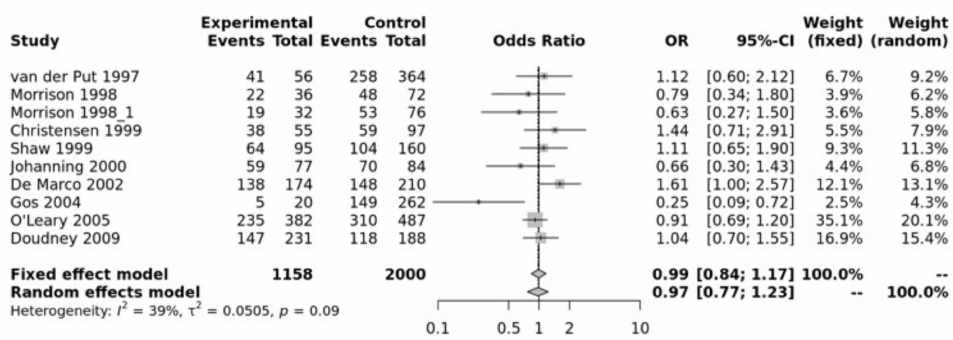
Figure 3. Recessive mode for MTR A2756G. Van Der Put [34], Morrison [60], Christensen [61],